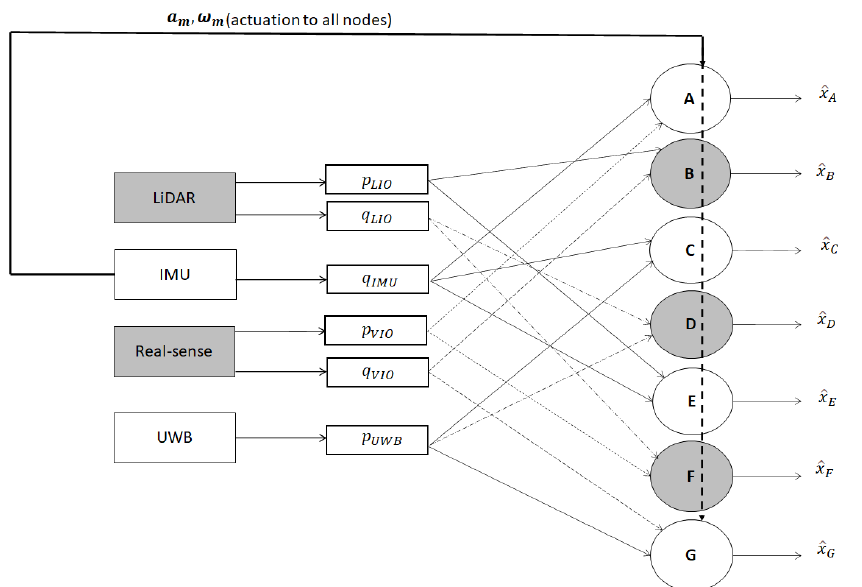
Figure 4. Combination of position and orientation information flow from various sensors in consti- tuting different nodes of the first